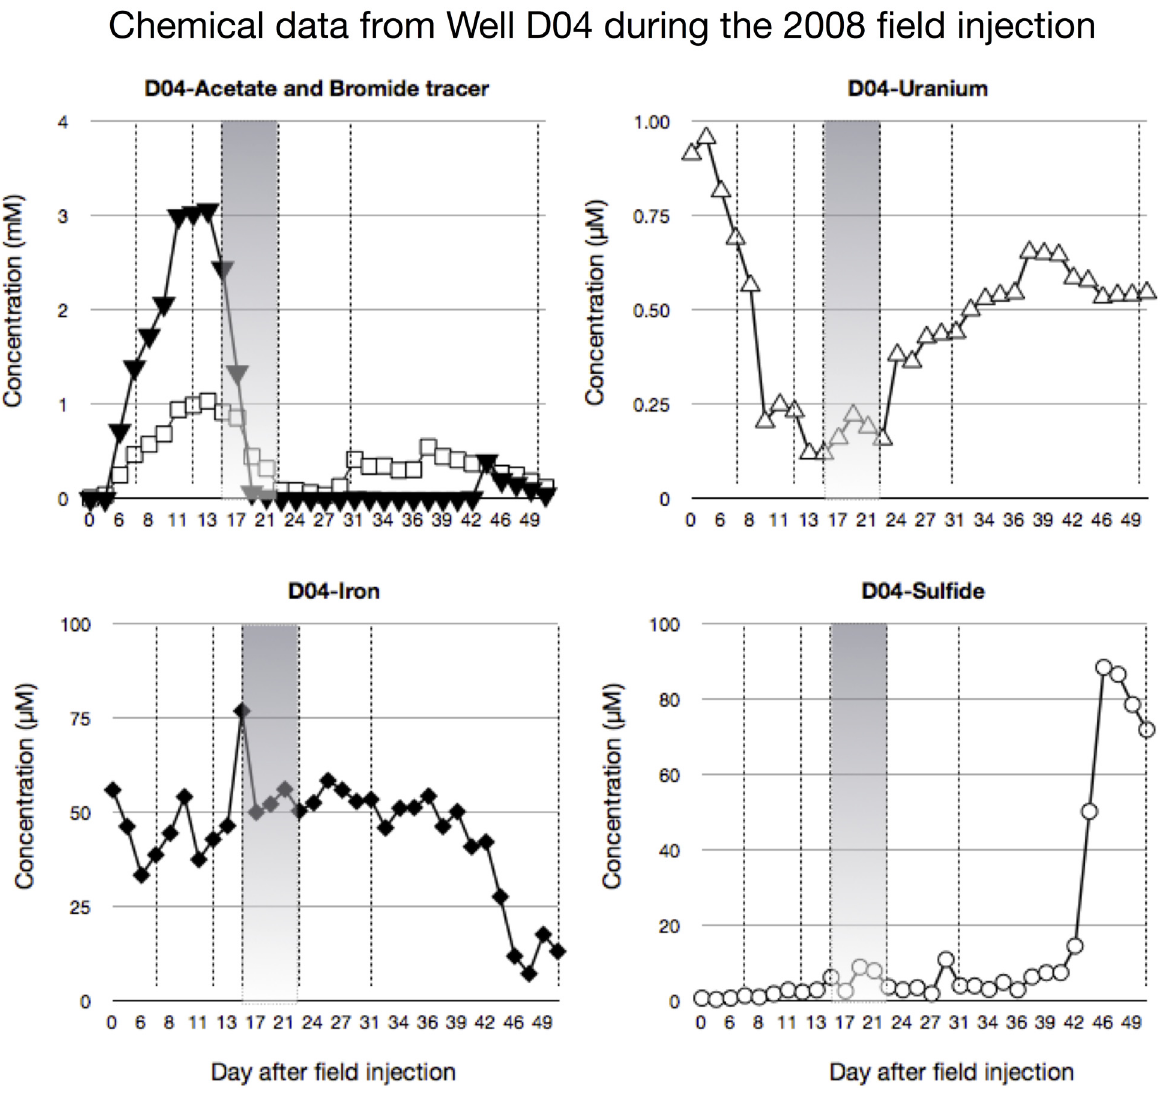
Fig 5. Chemical analysis of groundwater from well D04 during the 2008 field experiment-acetate (closed triangles) and bromide (open squares). The period of groundwater flush (shaded) and the times of biomass sampling (dotted line) are indicated. The chemical methods used in this analysis exhibit analytical variability in the femto-, nano-, and micro-molar range for uranium, iron/sulfide, and acetate respectively. All field measurements are beyond this